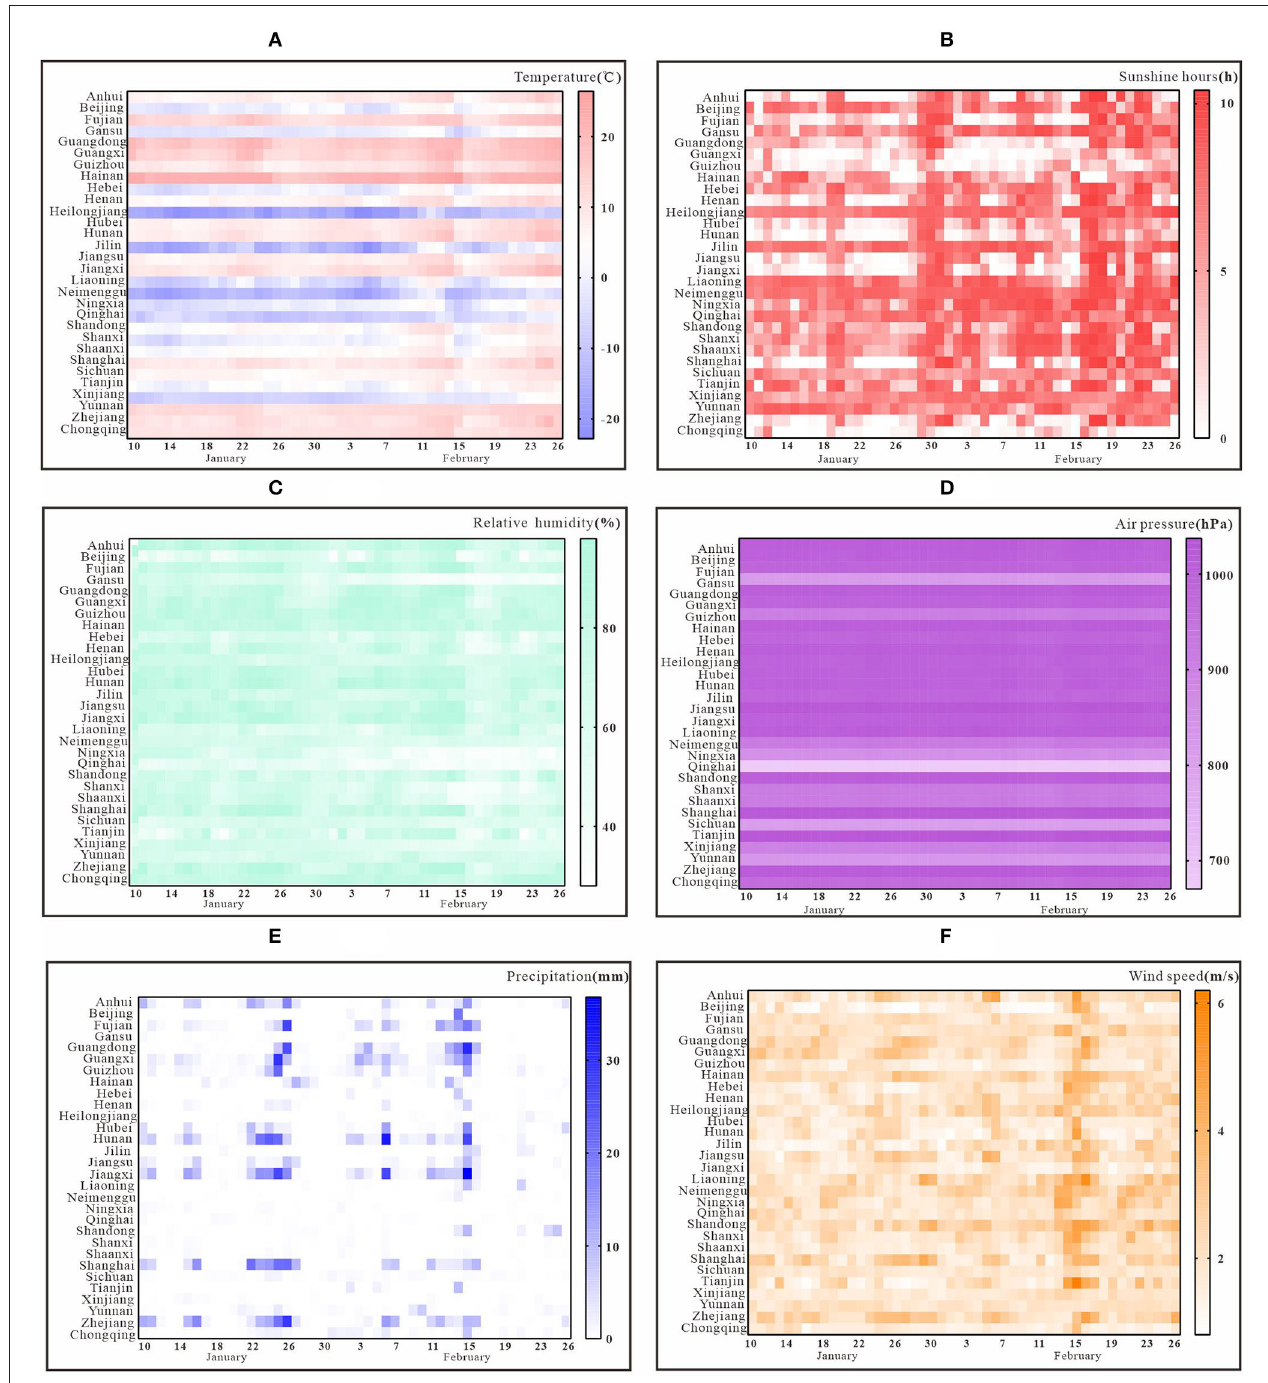
FIGURE 1 | Change in trend of key meteorological factors in 30 provinces and cities. (A) daily average temperature; (B) relative humidity; (C) precipitation; (D) sunshine hours; (E) air pressure; (F) wind